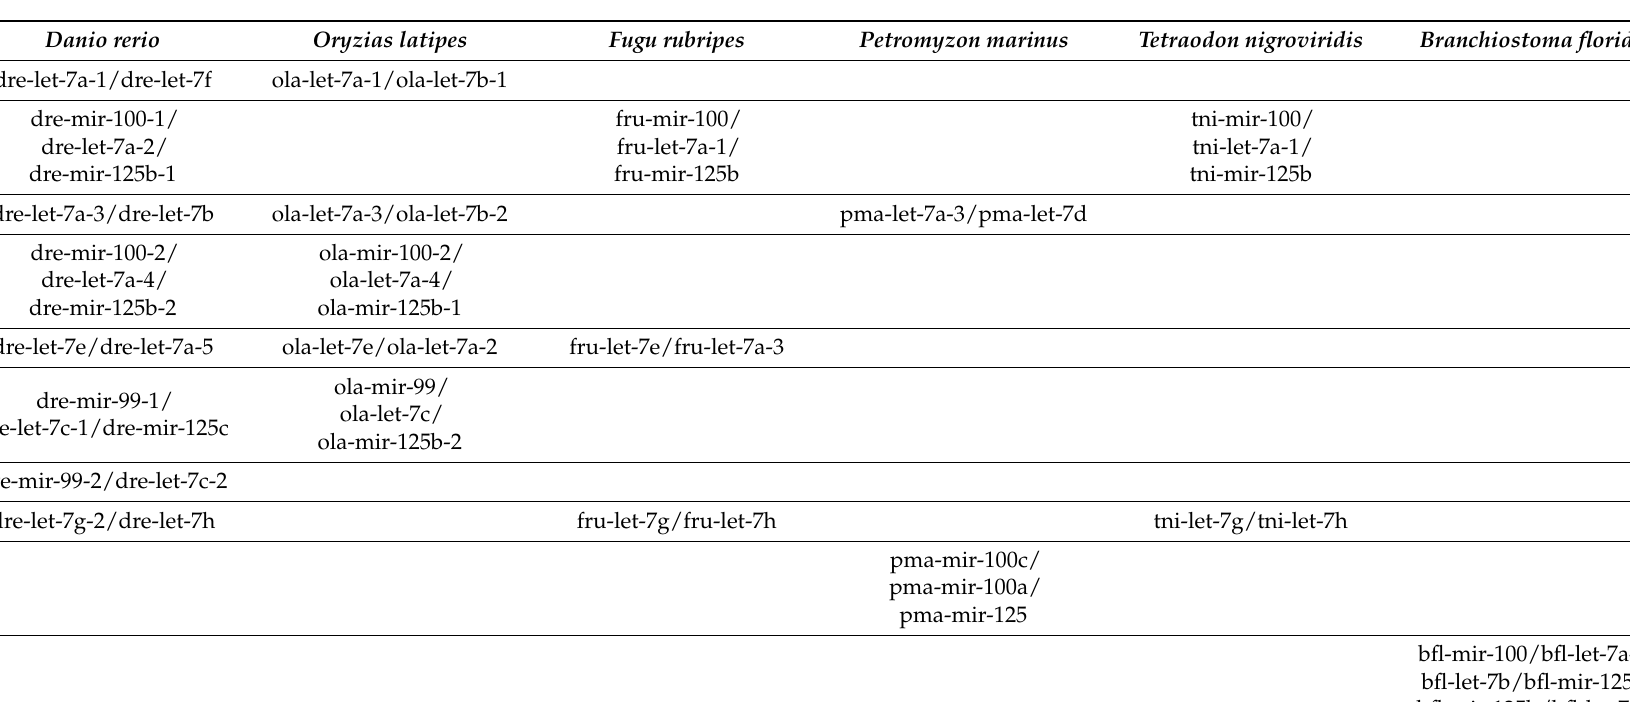
Table 1. The typical let-7 clusters identified in this